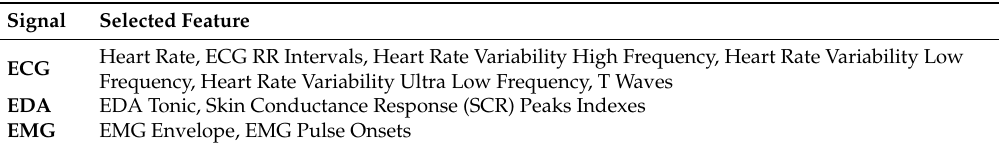
Table 2. Selected features for emotional classification, from electrocardiogram (ECG), electrodermal activity (EDA), and electromyogram (EMG).